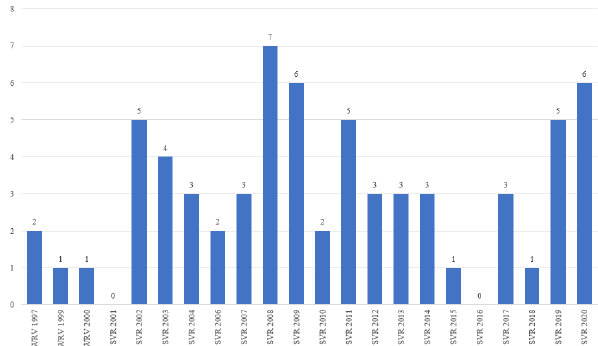
Figure 9. Overall distribution of papers from the “Computer graphics tech- niques for XR”